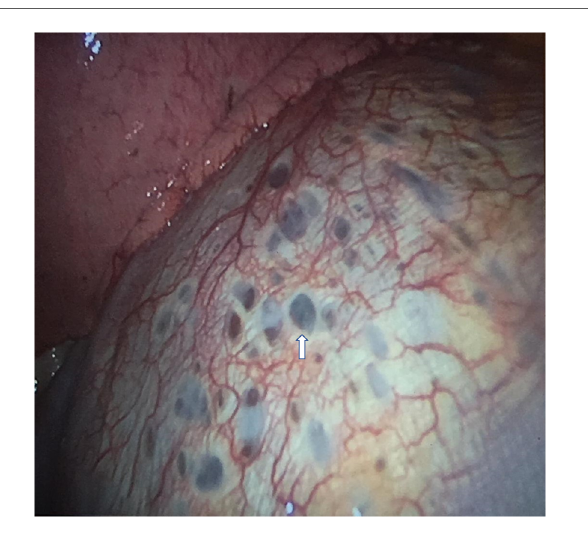
FIGURE 3 VATS intraoperative fi nding of typical diaphragmatic fenestrations (one indicated by white arrow), located at the central tendon of the diaphragm, in a patient with CP thoracic endometriosis-related. VATS, video-assisted thoracic surgery; CP, catamenial